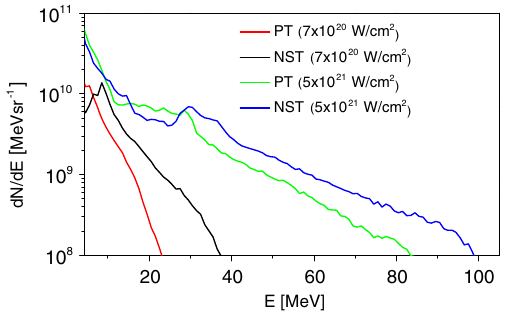
FIG. 2. Proton energy spectra for planar and nanosphere targets at the end of PIC